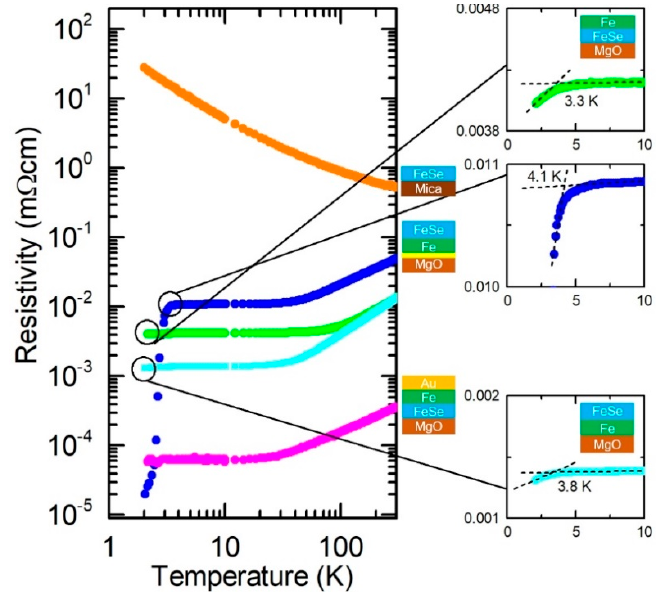
FeSe/Fe/MgO, Fe/FeSe/MgO, and Au/Fe/FeSe/MgO films. The schematic images illustrated at the vertical axis represent the films of various preparation conditions. Yellow lines at the FeSe/MgO, Fe/MgO, and FeSe/mica interfaces show the MgO and mica substrates pre-annealed in Se vapor. Dark blue and yellow lines at the film surface depict the films post- annealed in UHV and Se vapor, respectively. Open blue circles in the c FeSe window represent the FeSe thin films that show resistive signatures of superconductivity. Please note that most of the films were grown at a similar growth rate of 0.25 Ås -1 except the three examples as indicated. Note that the error in the c -axis lattice parameter evaluated from reproduci- bility tests would be ±0.004 Å for FeSe/Fe/MgO and ±0.007 Å for FeSe/MgO.